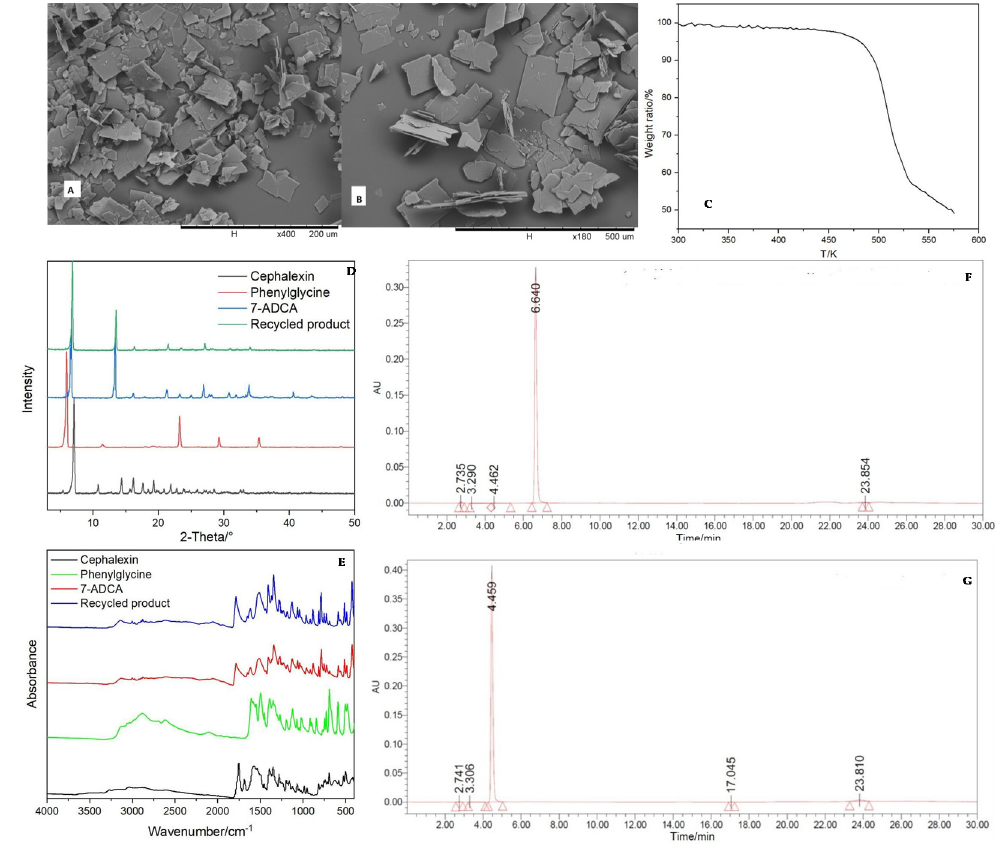
Figure 9. Scanning electron microscope (SEM) ( A , B ), thermogravimetry (TGA) ( C ), powder X-ray diffraction spectrum (PXRD) ( D ), infrared ( E ), and high-performance liquid chromatography (HPLC) ( F , G ) of cephalexin, phenylglycine, 7-ADCA, recovered 7-ADCA.